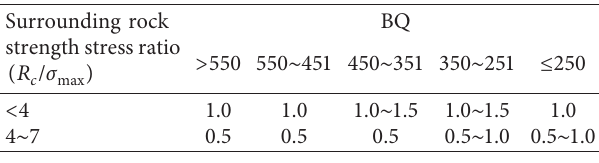
Table 5: Effect of initial stress state on correction factor K